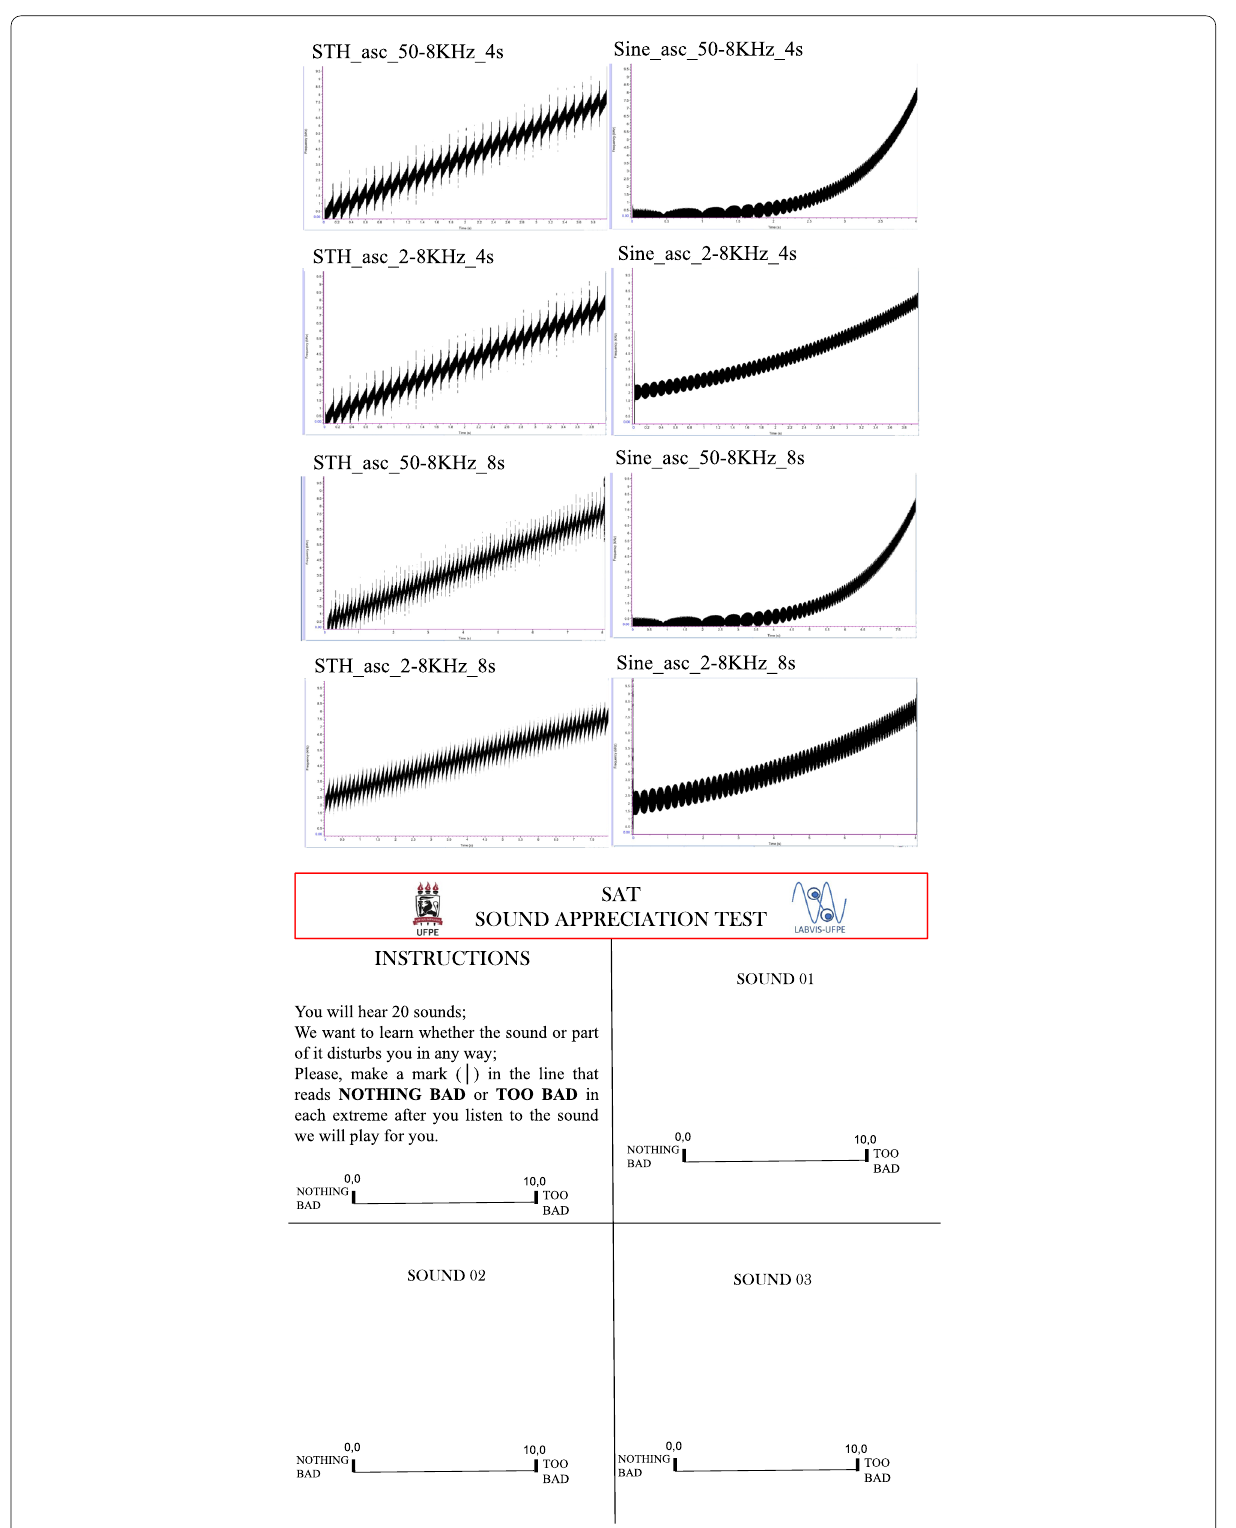
Fig. 1 Spectra from the specially designed pure tone frequency sweep stimuli in the ascending mode A and sample from the response pad used by FEP and HC volunteers B . Note: From de Bustamante Simas et al.